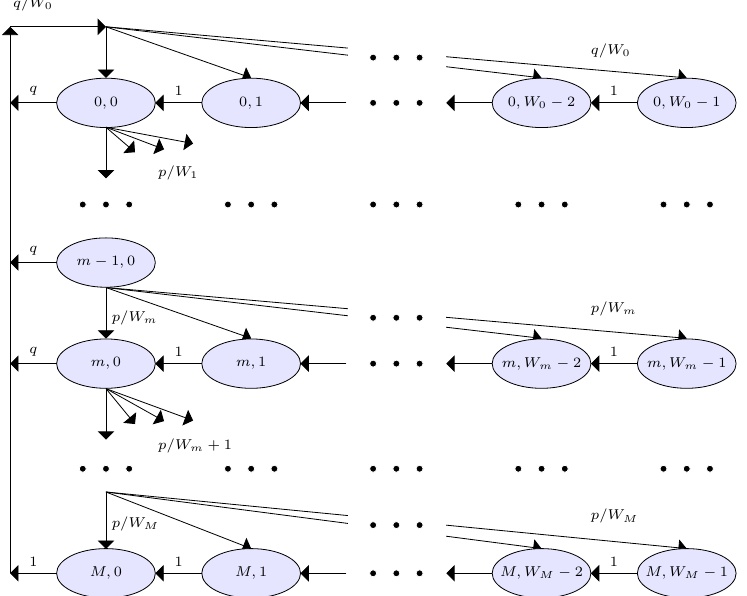
Figure 5. Markov chain model of the backoff process under HSMA/CA system. p , Failed transmission probability; q , Successful transmission probability; m , Backoff counter; M , Maximum retry limit; W 0 , Initial window size; W M , Maximum window